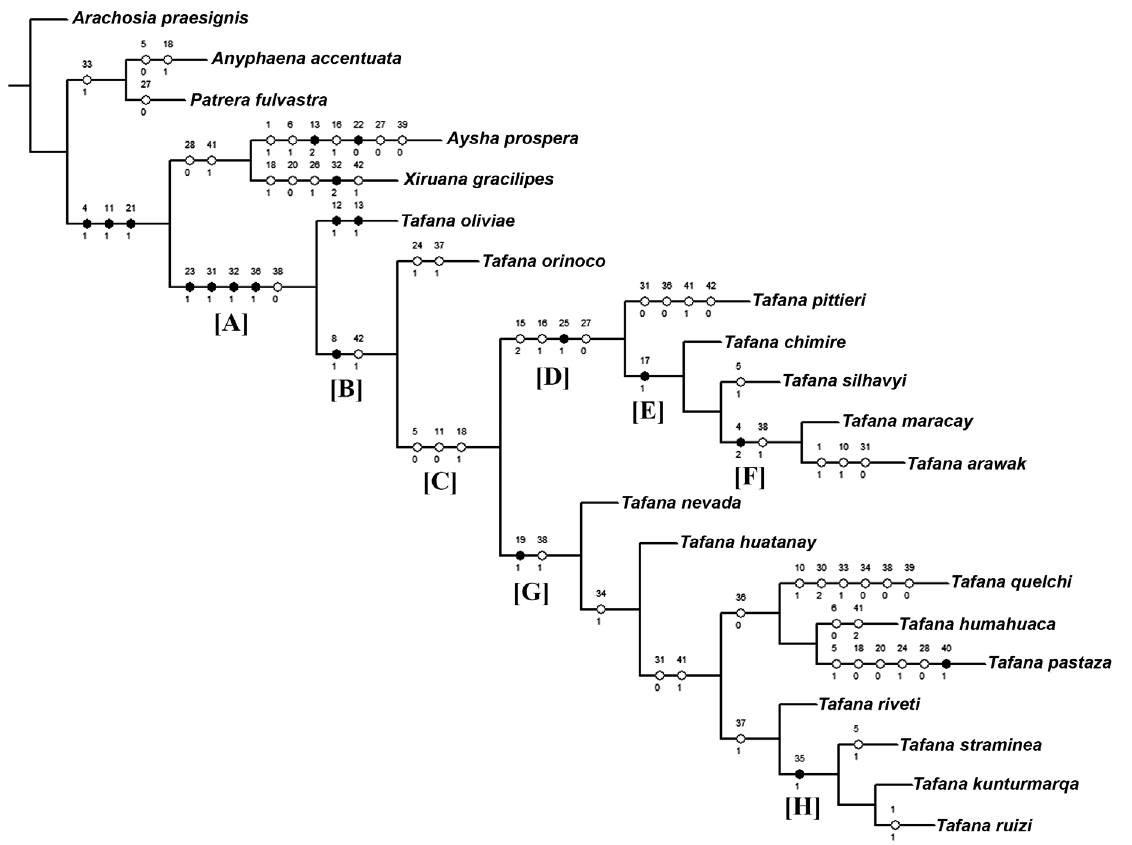
Fig. 5. Topology obtained under k = 7. Black circles indicate non-homoplastic synapomorphies. White circles indicate homoplastic synapomorphies. The code number of each character is indicated above and its respective state below. Letters denote clade names as referred to in the